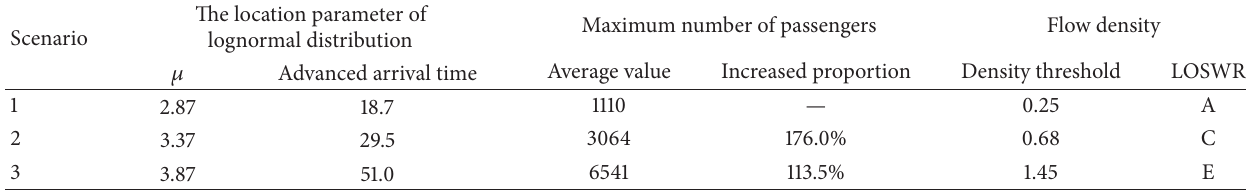
Table 7: The simulation results of railway passenger station waiting room ( 𝜇 ).